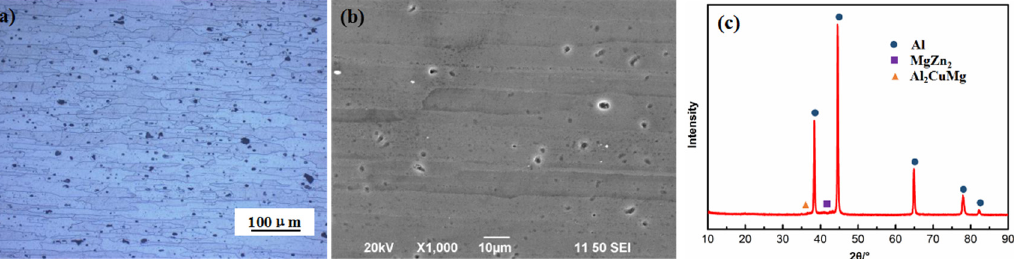
Figure 2. Original microstructure images of the 7075 alloy taken using ( a ) optical microscope, ( b ) SEM, and ( c ) XRD.